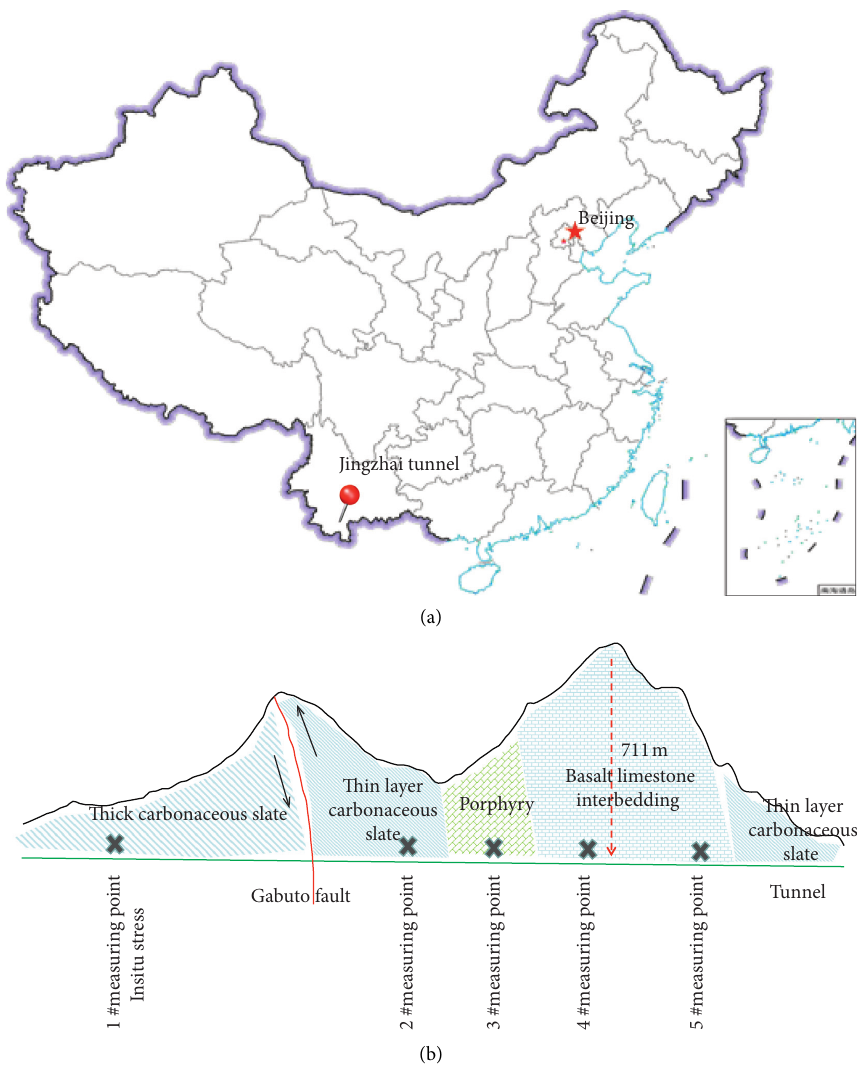
Figure 1: Research target location and geological section. (a) Research target tunnel location. (b) Tunnel profile and in situ stress measurement